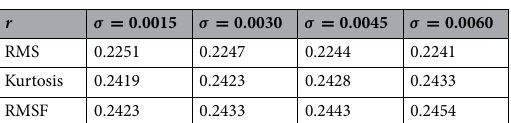
Table 5. Indicator reliability under different perturbation intensities.